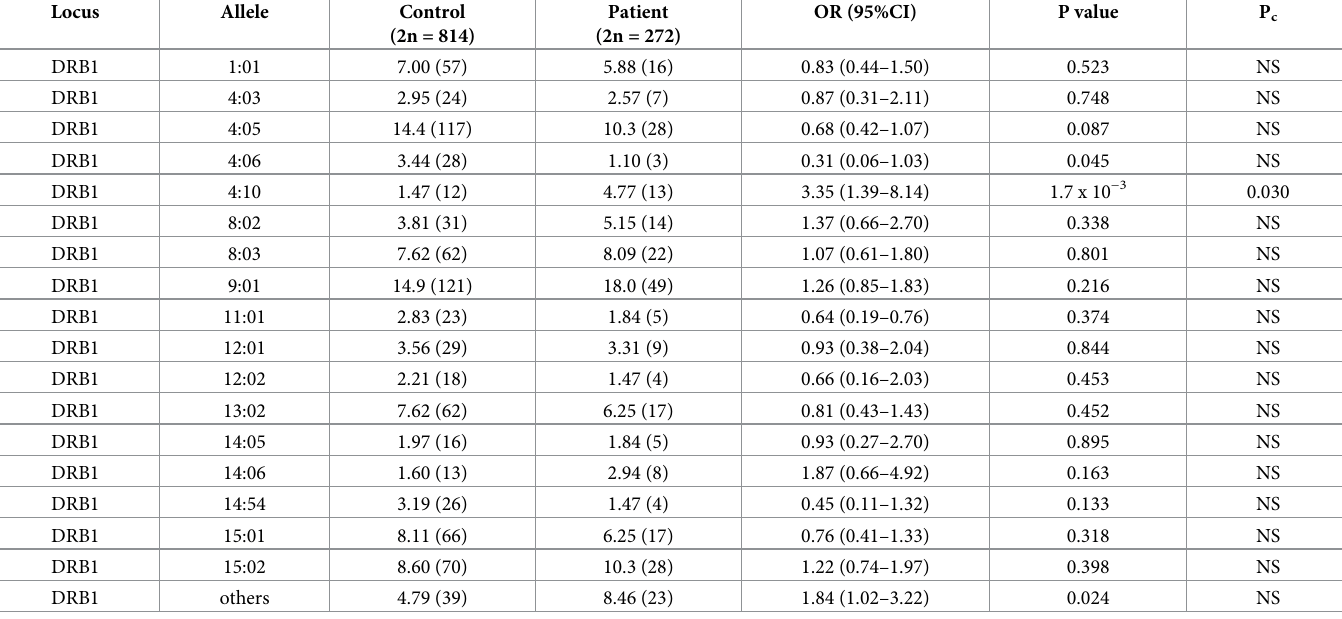
Table 1. Frequencies of HLA-DRB1 allele carrier in MMD patients and controls.